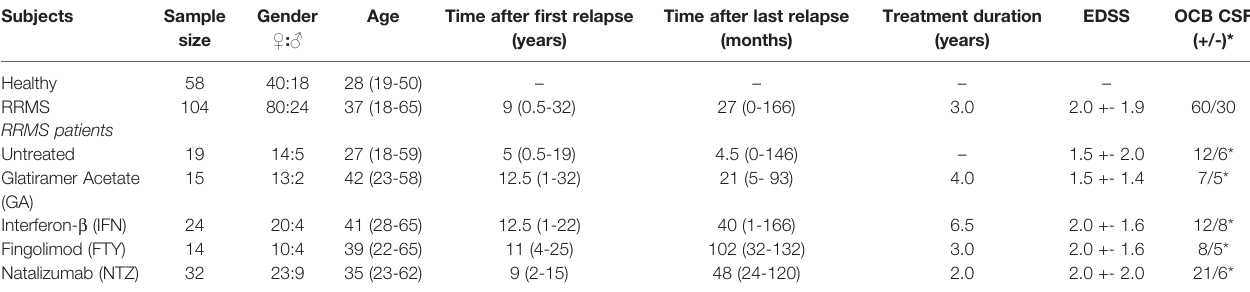
TABLE 1 | Demographic and baseline clinical characteristics of MS patients and